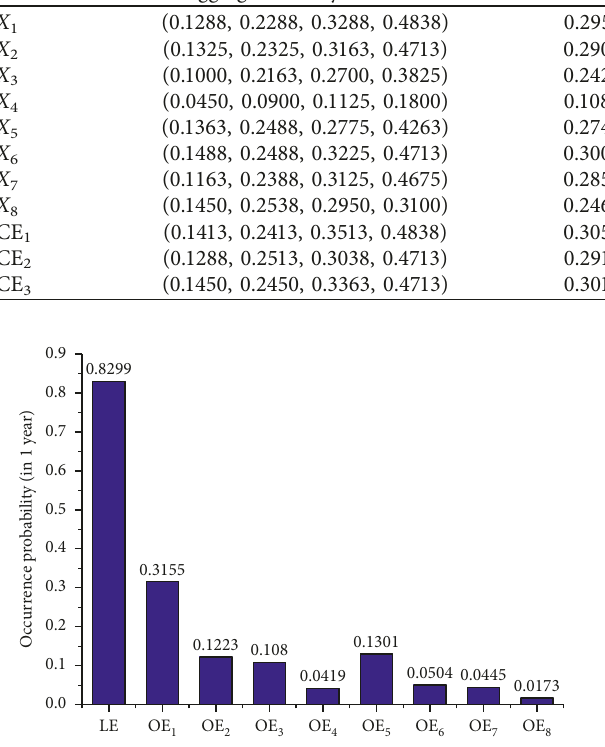
Figure 12: Occurrence probability of surface settlement and other outcome events. Table 15: Calculation of importance measure of influential factors. Symbol